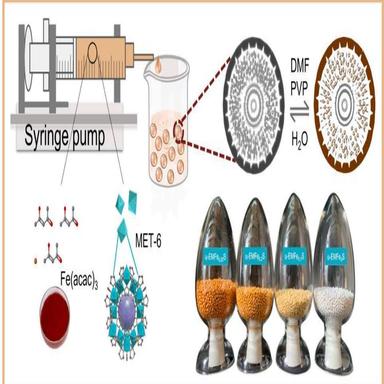
The process of precursor formation.